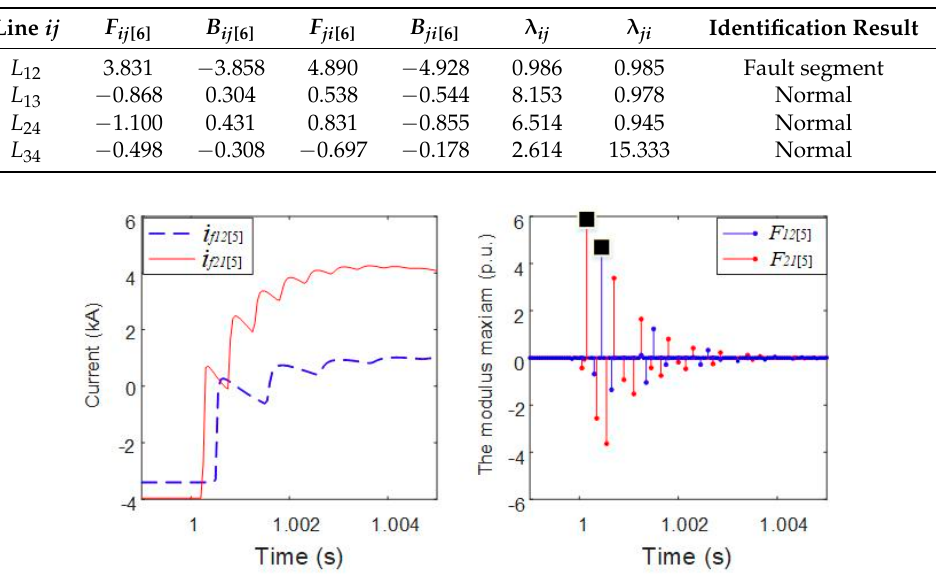
Figure 10. Simulation results of fifth mode FTWC.